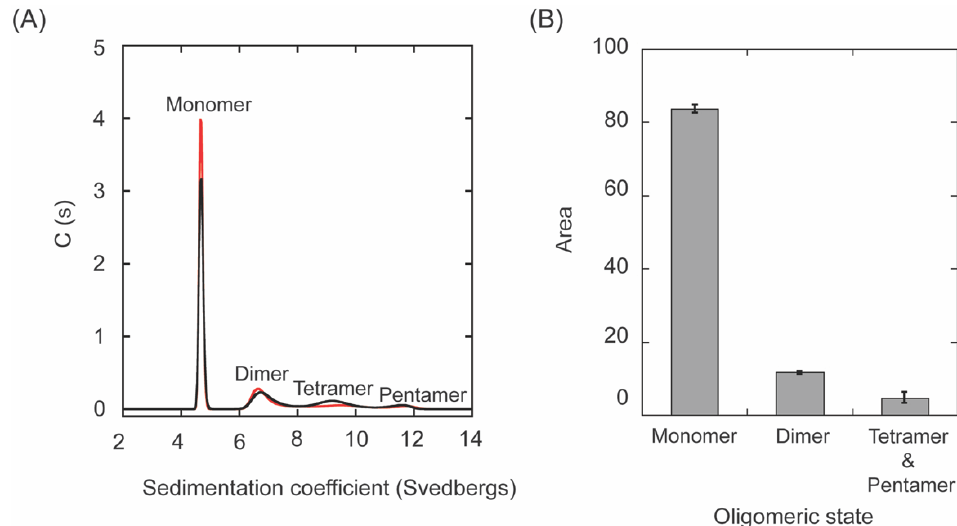
Figure 5. The oligomeric state of fl-LOXL2. ( A ) A representative run of SV-AUC with 0.88 mg/mL of fl-LOXL2. ( B ) A digitized graph showing the percentage of monomer, dimer, tetramer and pentamer of fl-LOXL2.